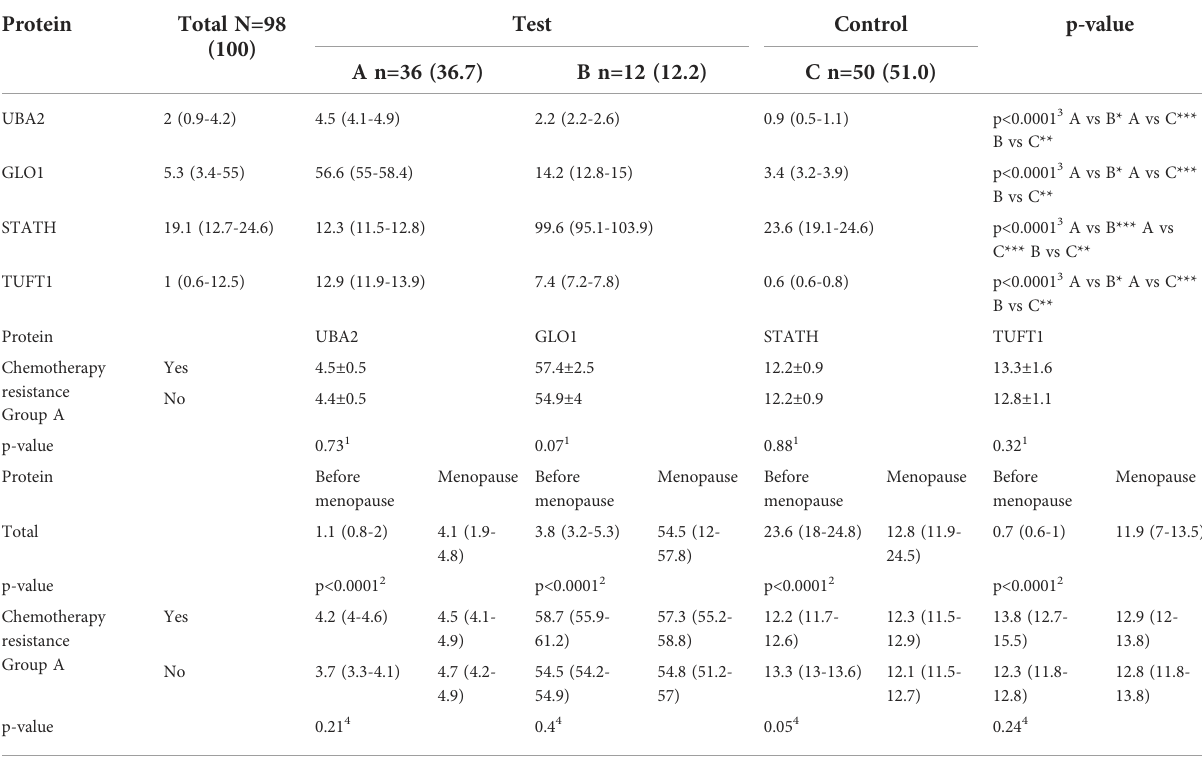
TABLE 5 Differences in the concentration of UBA2, GLO1, TUFT1, and STATH in the study (A and B) and control (C) groups obtained by ELISA assay, and their relationship with chemotherapy resistance including patients undergoing chromotherapy (in A group) and menopause (total and in A